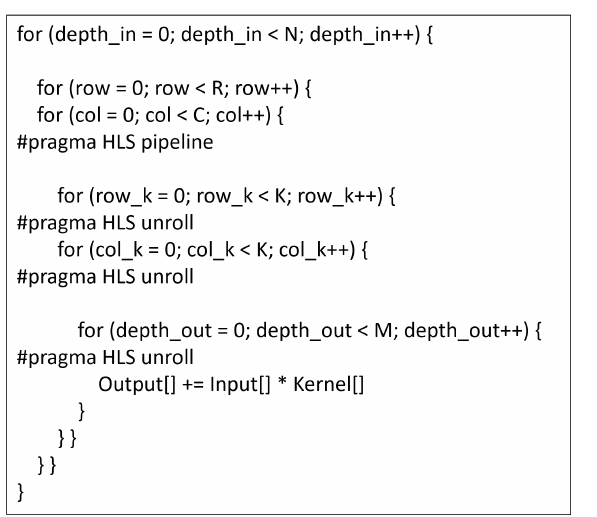
Figure 9. Pseudocode for a convolutional layer with pragma